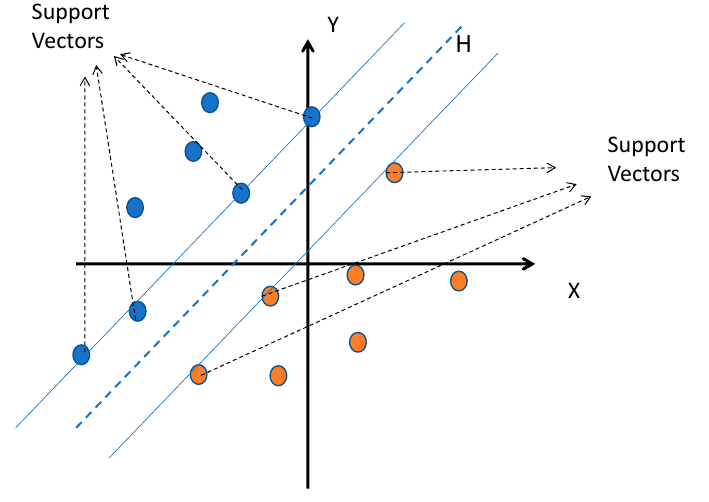
Figure 3. Support vectors. Figure 3. Support